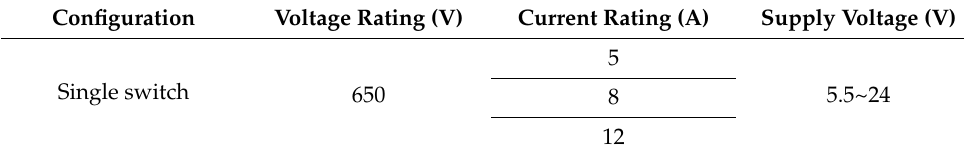
Table 28. Commercial switch-driver-integrated module by Navitas